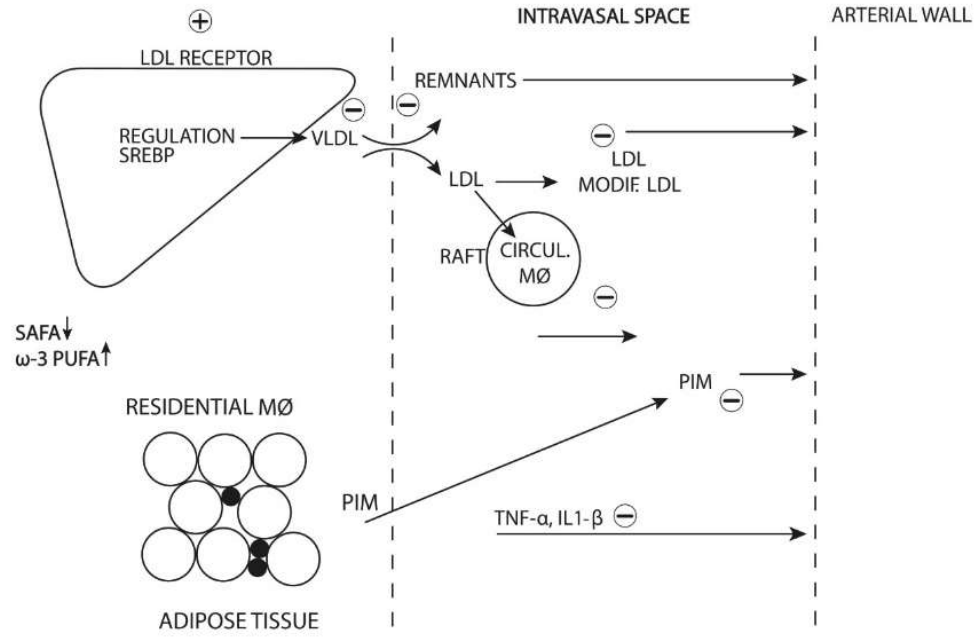
Figure 5. Metabolic changes associated with the decrease in FAs and increase in n-3 PUFA con- sumption are related to LDL receptors in the liver (mainly) and decreasing of LDL particles in the circulation. At the same time, VLDL synthesis is downregulated and, consequently, the levels of VLDL remnants decline. Changes in SAFAs/n-3 PUFAs decrease PIM polarization in adipose tissue and slow down the production of TNF- α and proinflammatory interleukins. In addition, a decrease in cholesterol levels in the intravascular space impairs its transport to the lipid rafts of circulating monocytes, thus, reducing their inflammation. All these changes attenuate atherogenesis and stabilize pre-existing plaques. All arrows represent metabolites or cells shift. +/ − represents increase or decrease of metabolic rate or number.